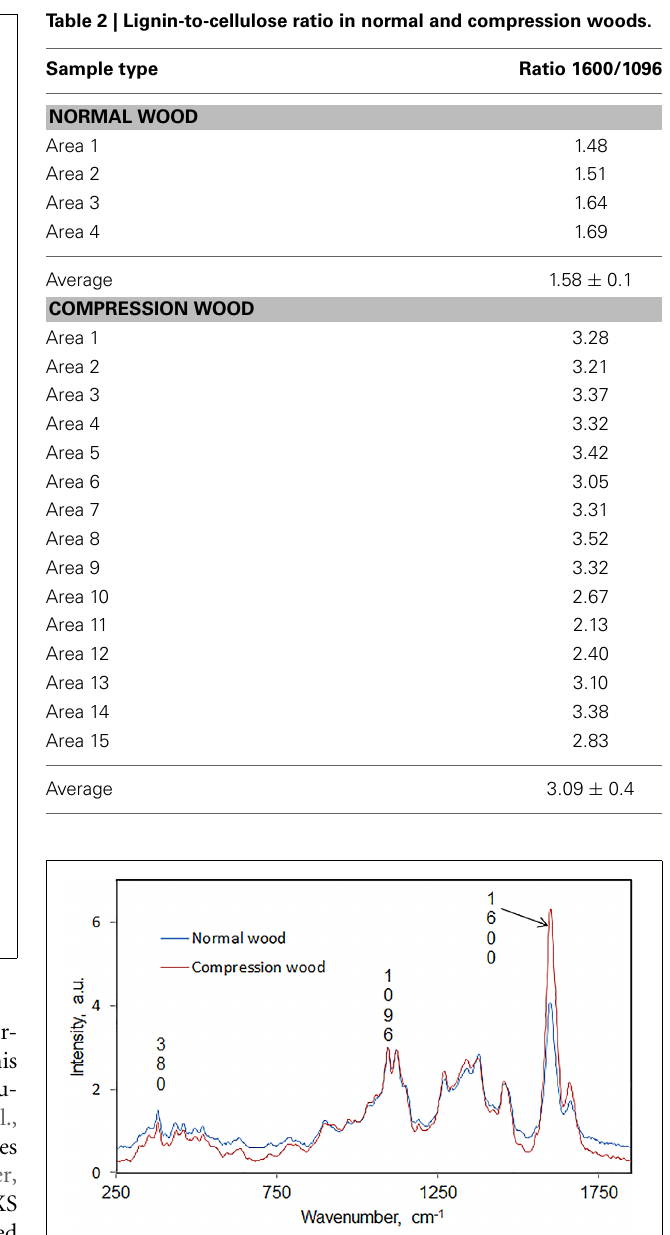
FIGURE 2 | Average Raman spectra, in the region 250–1850cm − 1 , comparing normal and compression wood of black